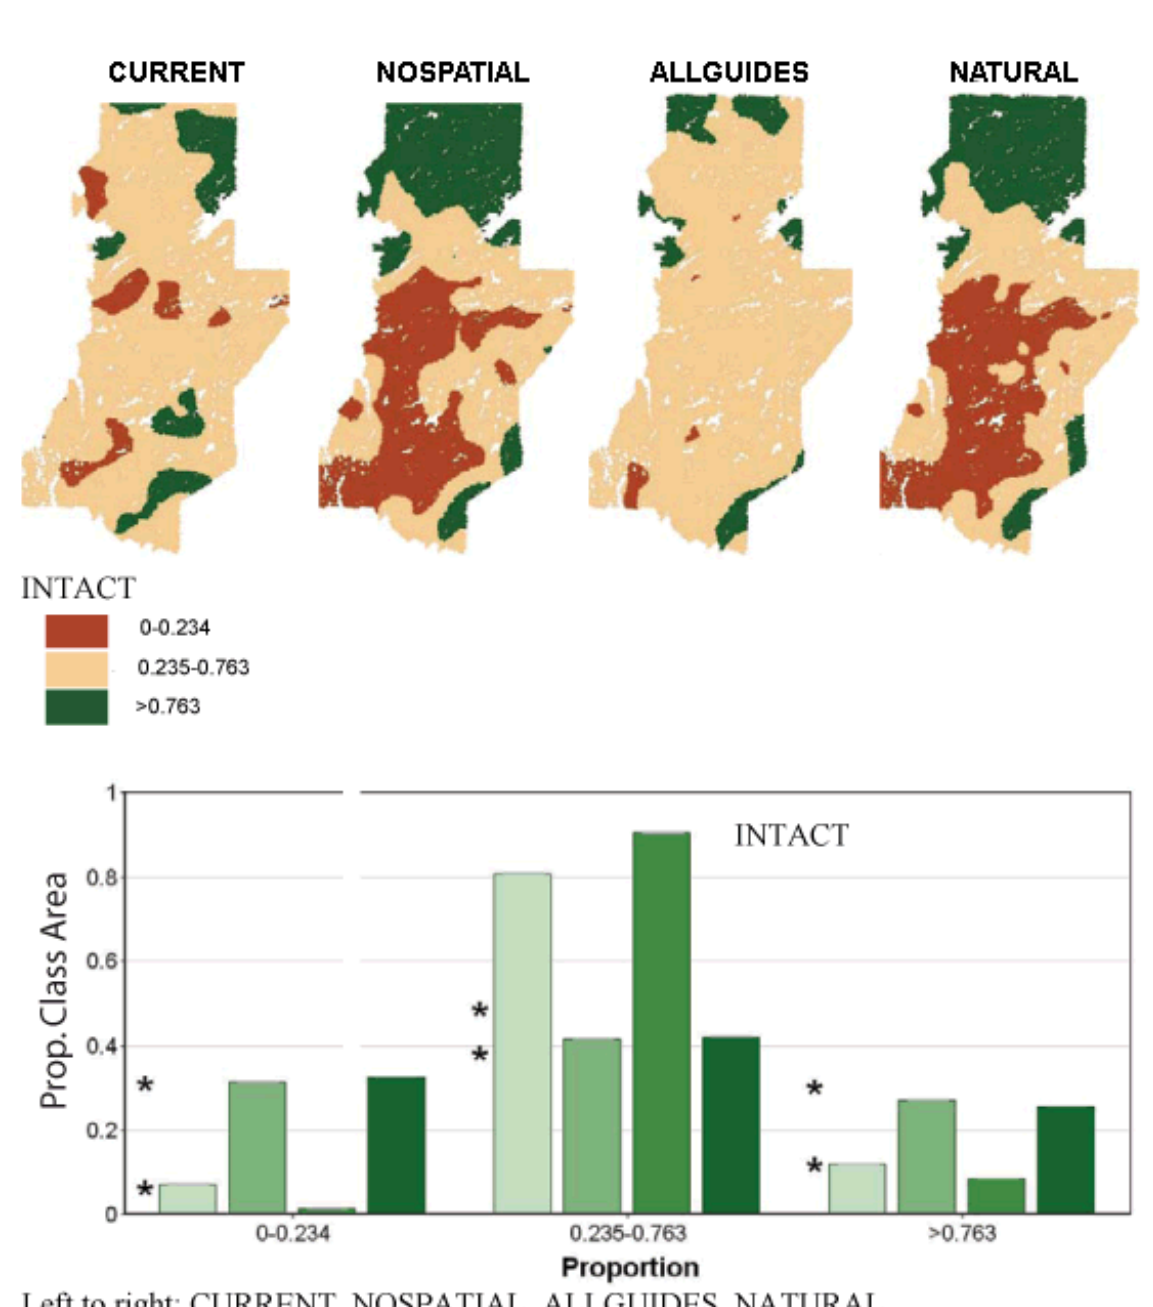
Fig. 9. Spatial pattern signatures for percent mature and old forest (INTACT) based on Patchworks projections (year 100) of four management scenarios (see Table 2 for definitions). Histograms depict proportion of map-area for low, medium, and high INTACT for each of the four scenarios, and asterisks represent SRNV for INTACT. Proportions are treated as percentages for